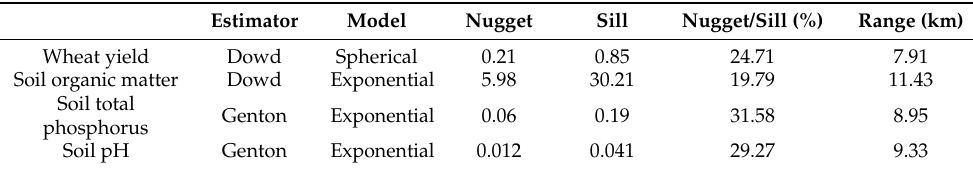
Table 4. Parameters of the optimal robust variogram